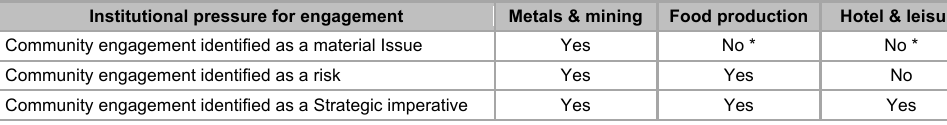
Institutional pressure for